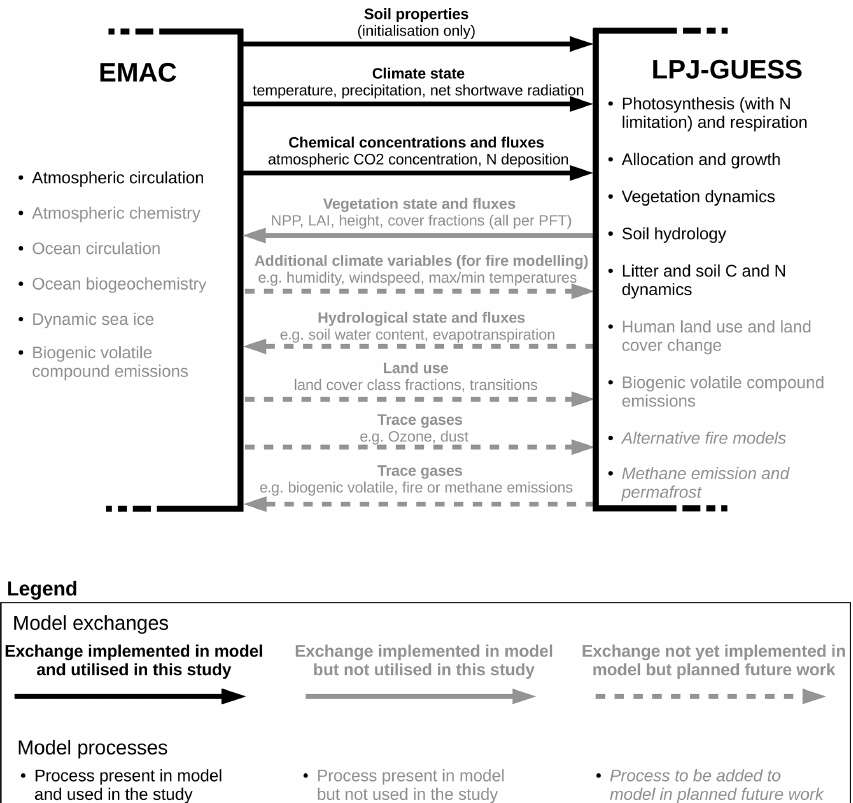
Figure 1. The main processes and exchanges in the coupled model framework. Processes and exchanges with normal black text and black solid arrows are included in the framework and used in the simulations presented here; processes and exchanges with normal grey text and grey solid arrows are included in the framework but not used in the simulations presented here; and processes and exchanges with italic grey text and grey dotted arrows are not included in the framework but planned in future work. All exchanges happen on a daily basis, except for soil properties, which happen only during the initialisation